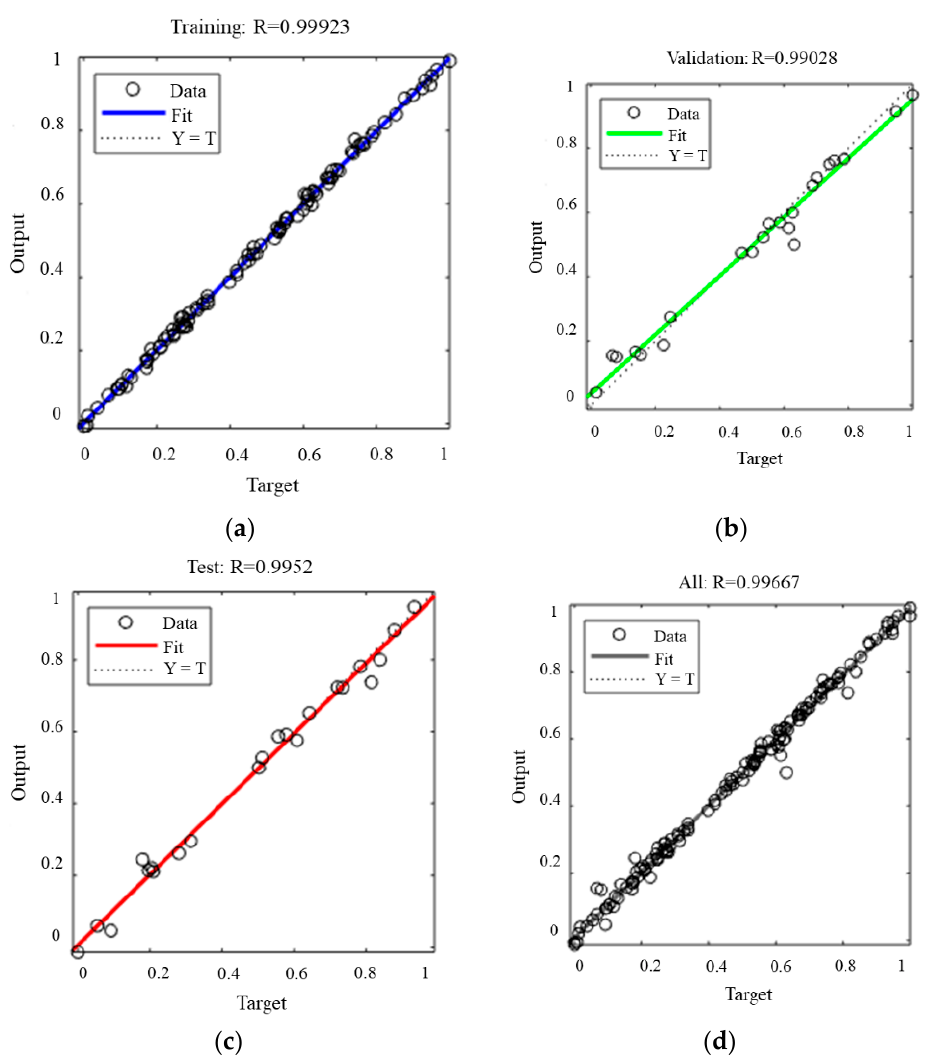
Figure 14. Performance of BPNN. ( a ) Fitting situation of the training group; ( b ) fitting situation of the validation group; ( c ) fitting situation of the test group; ( d ) fitting situation of all groups.